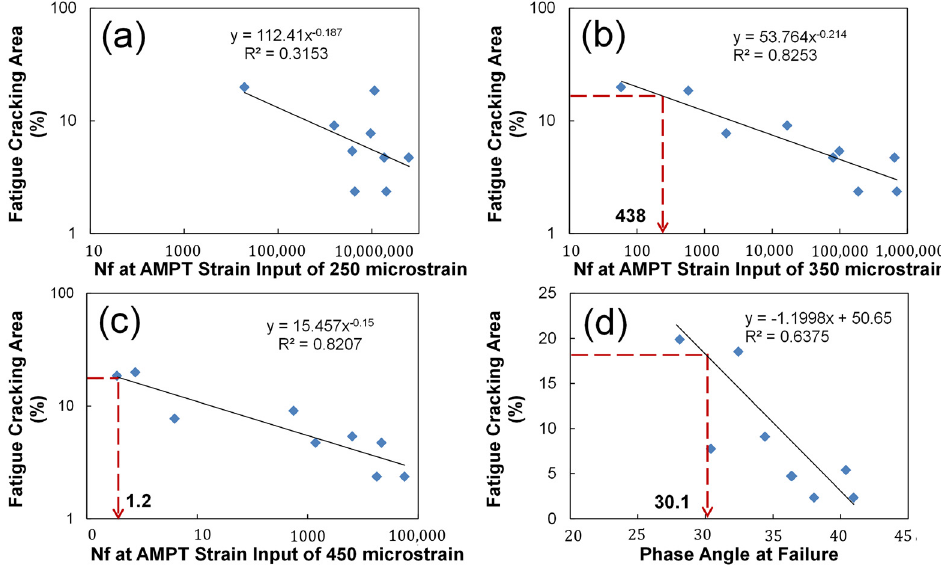
Figure 14. Identification of the optimal fatigue cracking index and its performance threshold value: ( a ) 250 micro-strain; ( b ) 350 micro-strain; ( c ) 450 micro-strain; ( d ) Phase angle at failure.